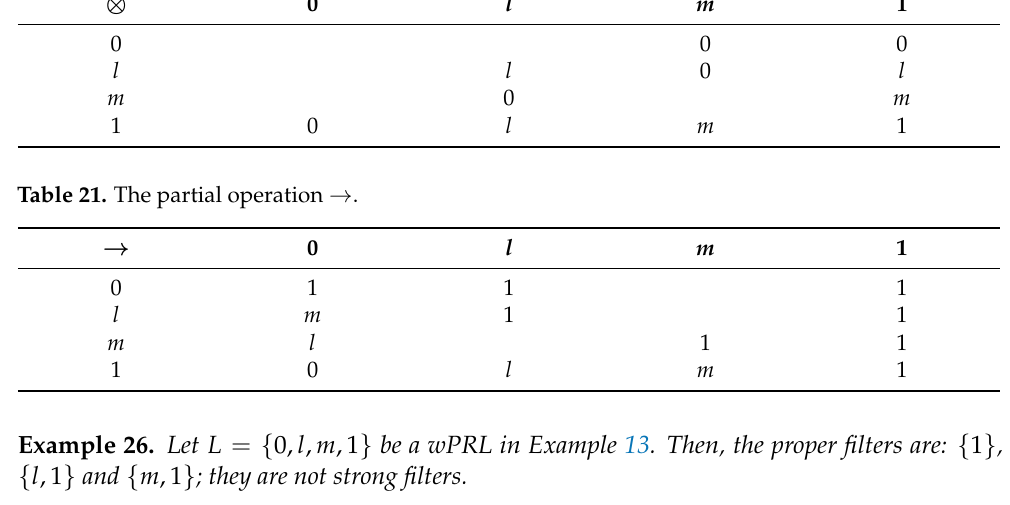
Table 20. The partial operation ⊗ . ⊗ 0 l m 1